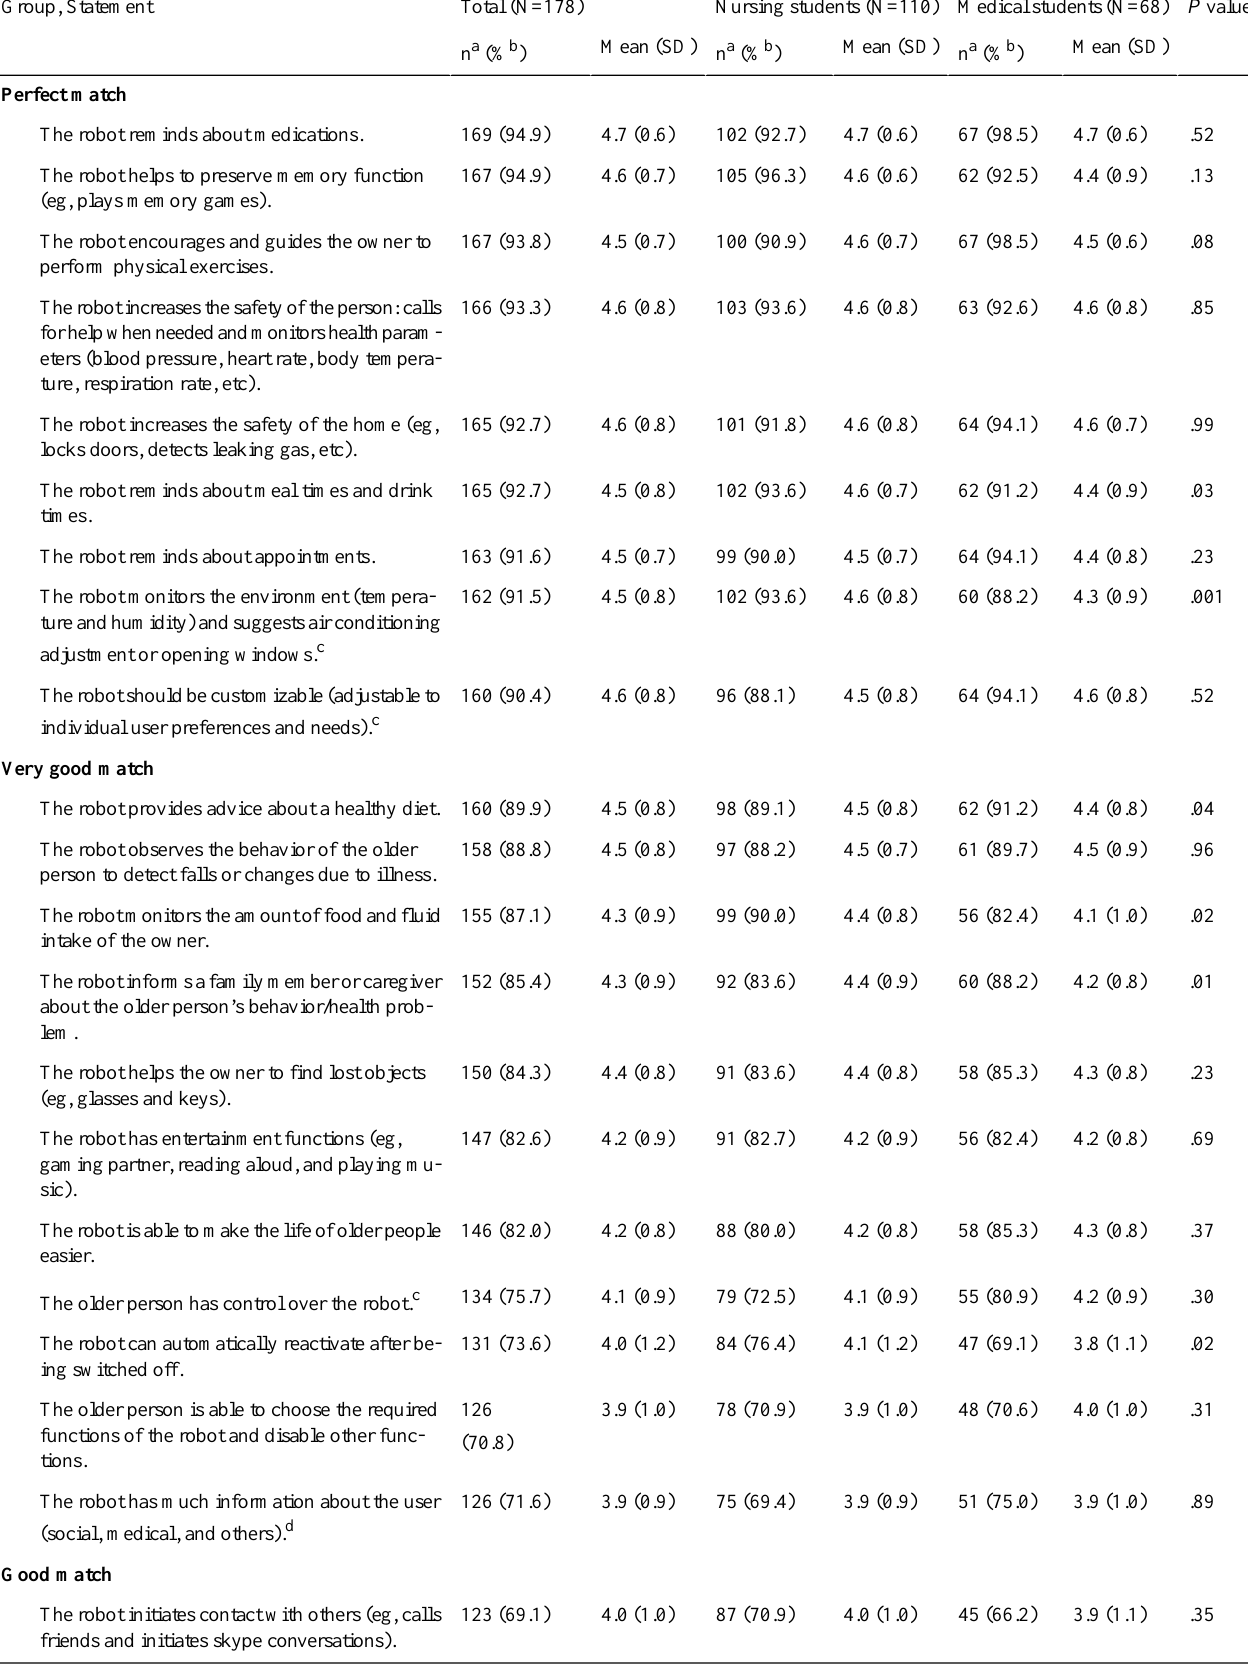
Table 2. Opinions of nursing and medical students related to statements about the specific functions of a robot in the care of older people, arranged by the percentage of students who agreed with the